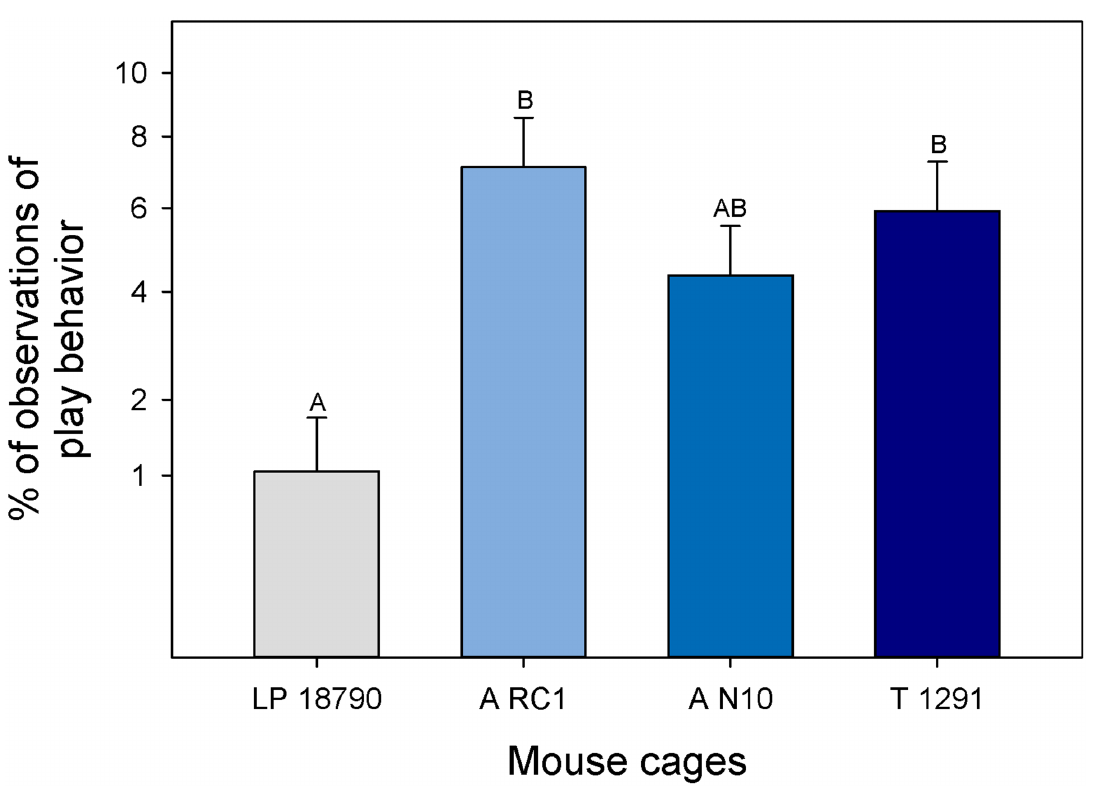
Fig 3. Proportion of play behavior observed in the different cage sizes. Least square means and standard errors are plotted against an angularly transformed y-axis. Post hoc Tukey tests were considered significant if P < 0.05. Different letters indicate statistical differences (P <